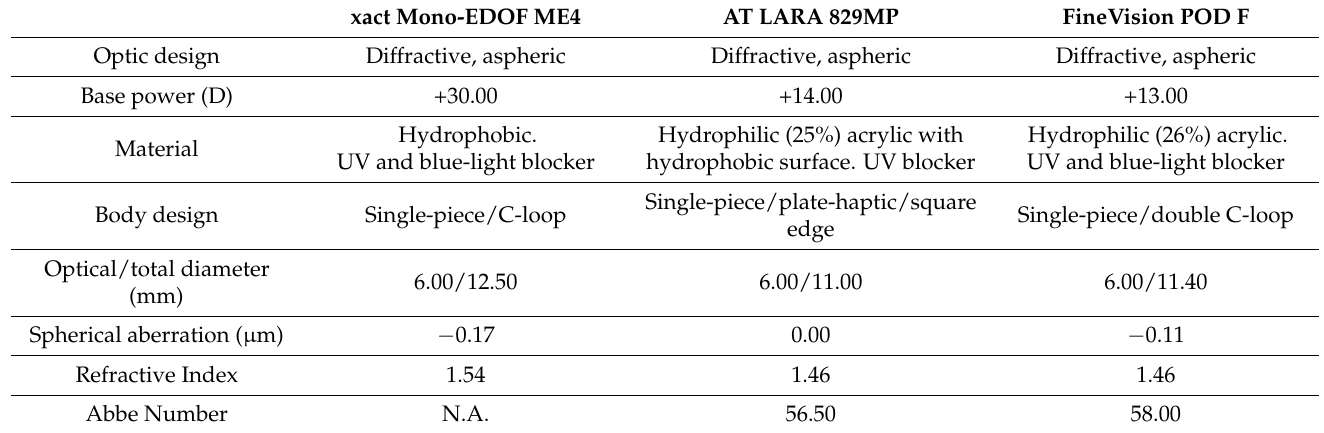
Table 1. Main specifications of the three IOLs included in this study.